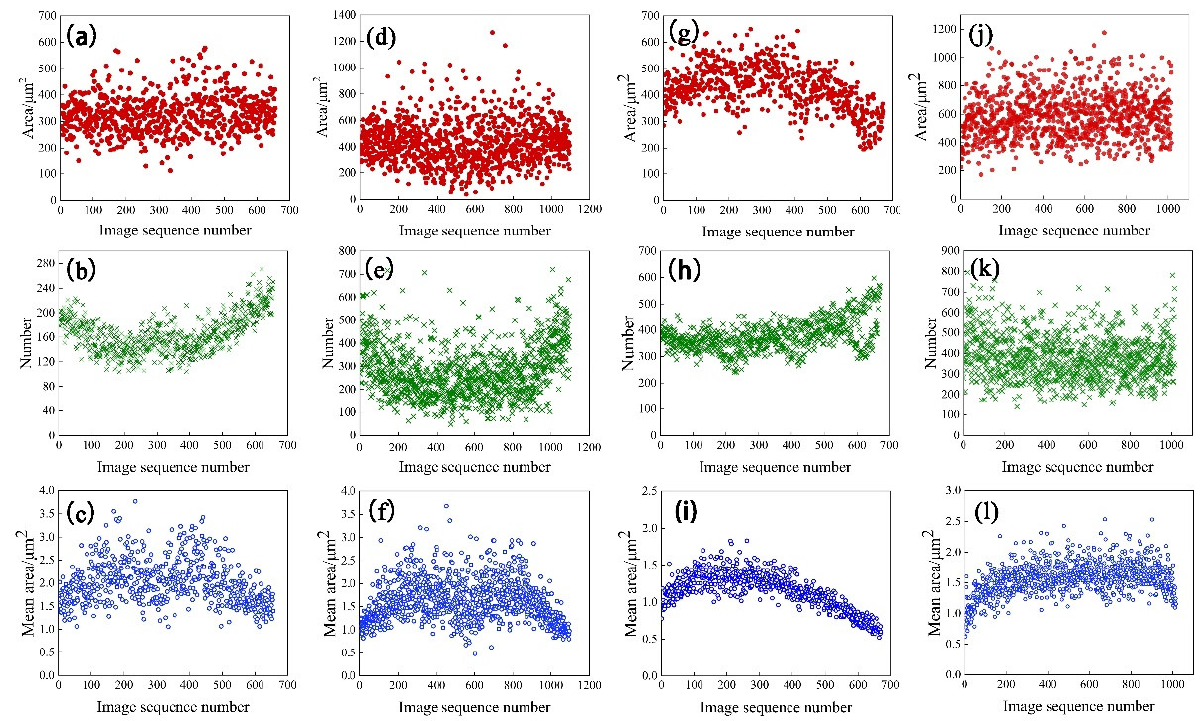
Figure 6. The total area, quantity and average area distribution of insoluble phases along the thick- ness direction in 7B05 aluminum alloy: ( a – c ) T4-6; ( d – f ) T4-15: ( g – i ) T5-10; ( j – l ) T5-15.